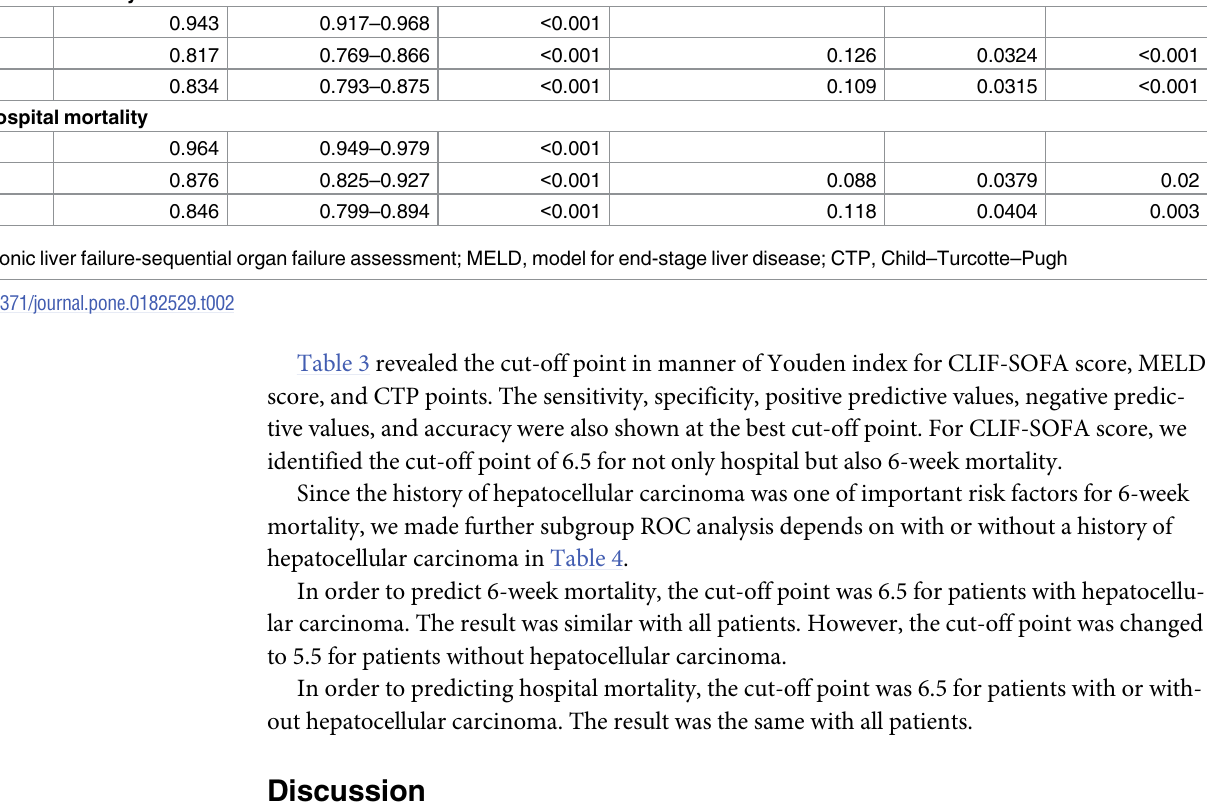
Table 2. Pairwise comparison of area under the receiveroperator characteristics (AUROC).